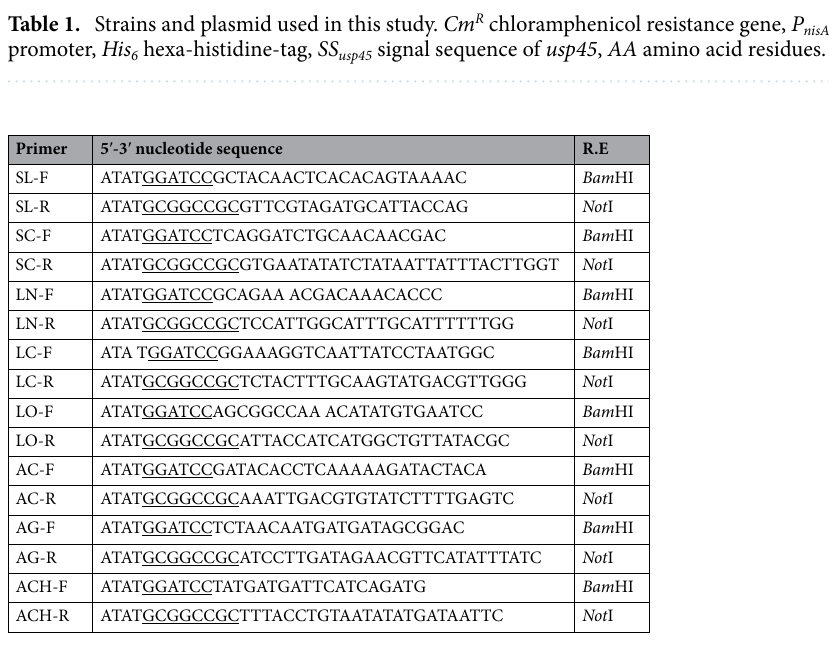
Table 2. Primers used for the construction of expression plasmids. Restriction endonuclease (R.E.) cleavage sites are underlined. -F forward primer, -R reverse